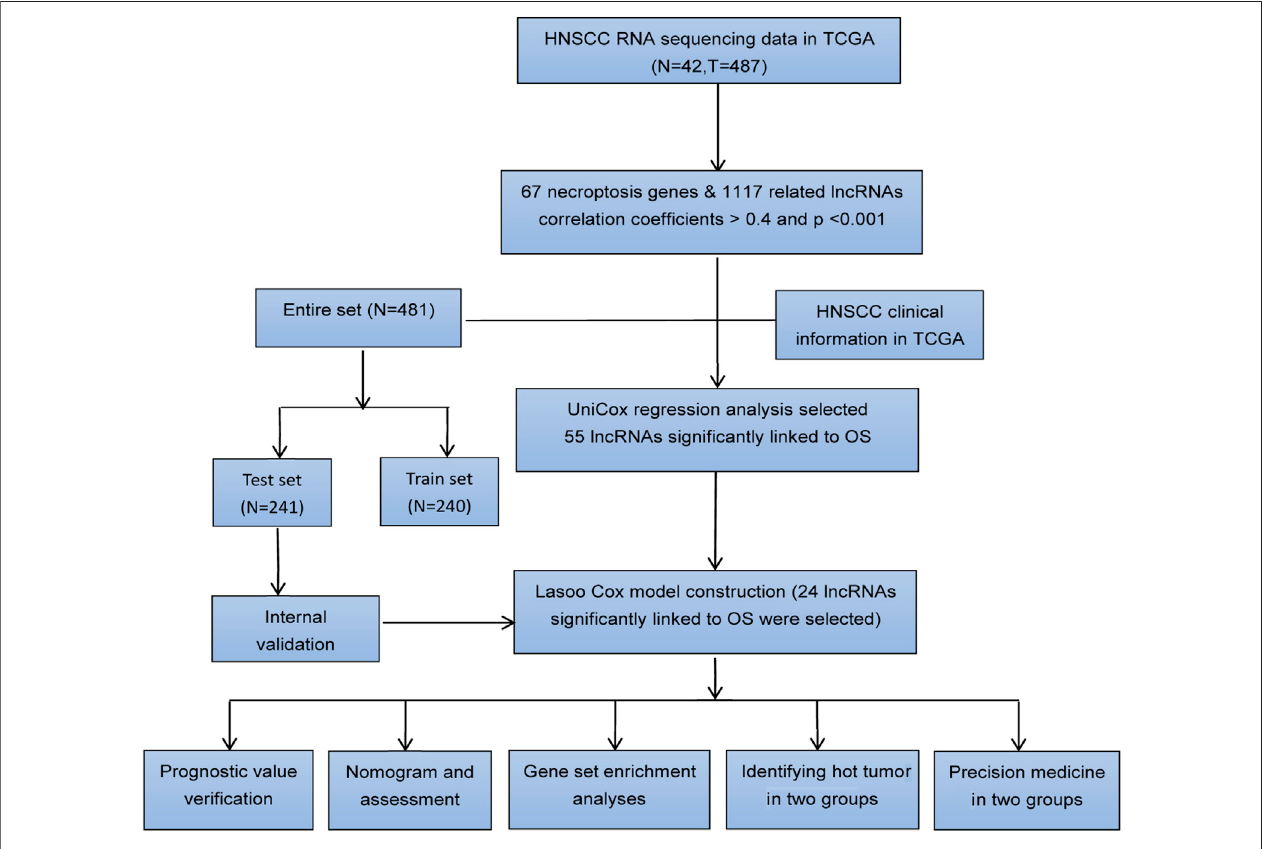
FIGURE 1 | Work fl ow diagram of data